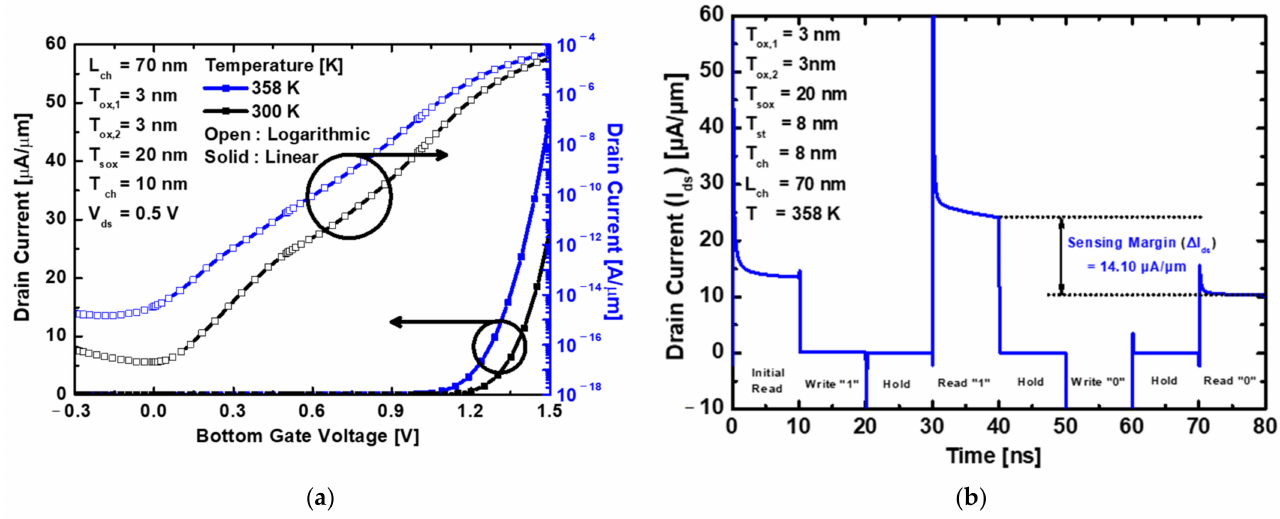
Figure 4. ( a ) Linear (solid symbol) and logarithmic (open symbol) I ds -V gs,B transfer characteristics for the proposed 1T-DRAM at V ds = 0.5 V. ( b ) Transient characteristic of the proposed